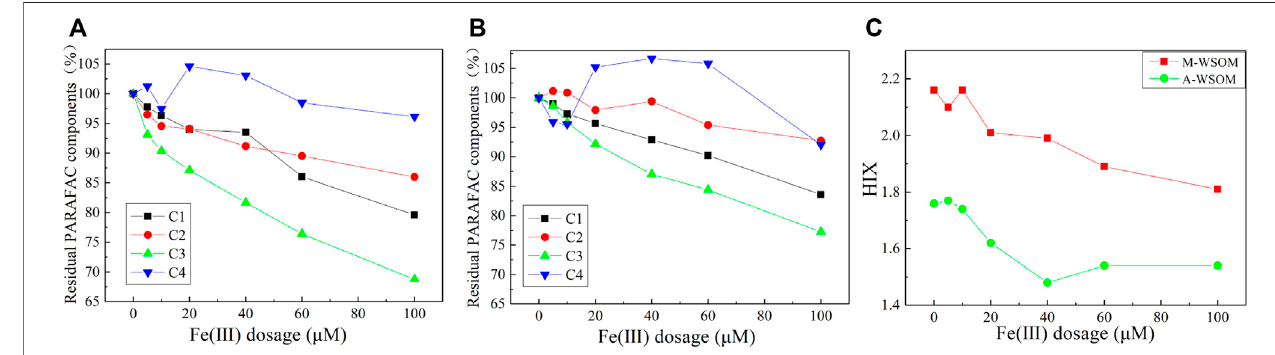
FIGURE5| Residual percentage offour PARAFAC components ofM-WSOM (A) and A-WSOM (B) after coprecipitation underdifferentFe (III) dosages(pH = 6.5), and the effect of Fe (III) dosage on values of HIX of WSOM after coprecipitation with Fe and P (pH = 6.5) (C) .